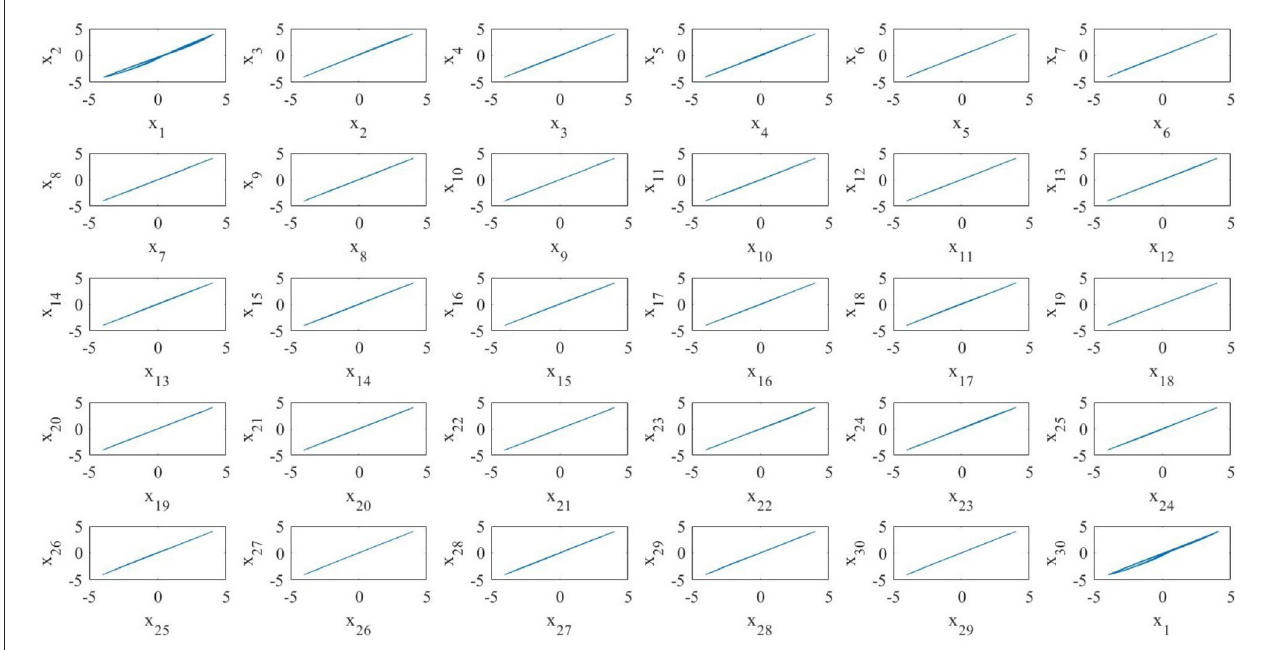
FIGURE 8 | A realization of a blinking array of N = 30 MOCs. All the oscillators synchronize in phase.